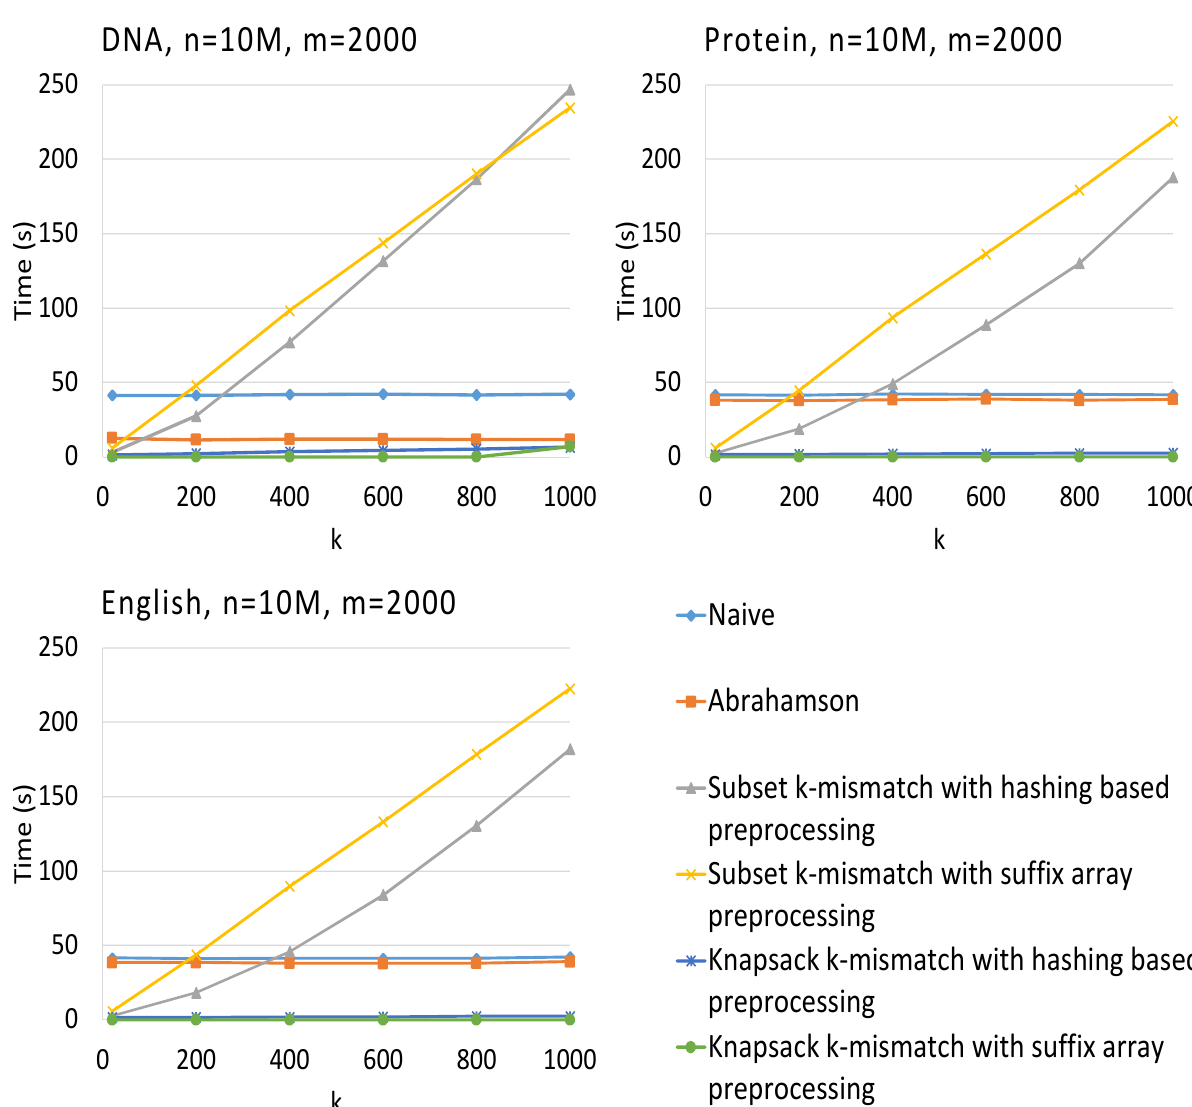
Figure 3. Run times for pattern matching on DNA, protein and English alphabet data, when the maximum number of mismatches allowed ( k ) varies. The length of the text is n = 10 millions. The length of the pattern is m = 2000 . Our algorithms are subset k mismatch with hashing-based preprocessing (Section 2.2.2), subset k mismatch with suffix array preprocessing (Section 2.2.2), knapsack k mismatch with hashing-based preprocessing (Section 2.2.3) and knapsack k mismatch with suffix array preprocessing (Section